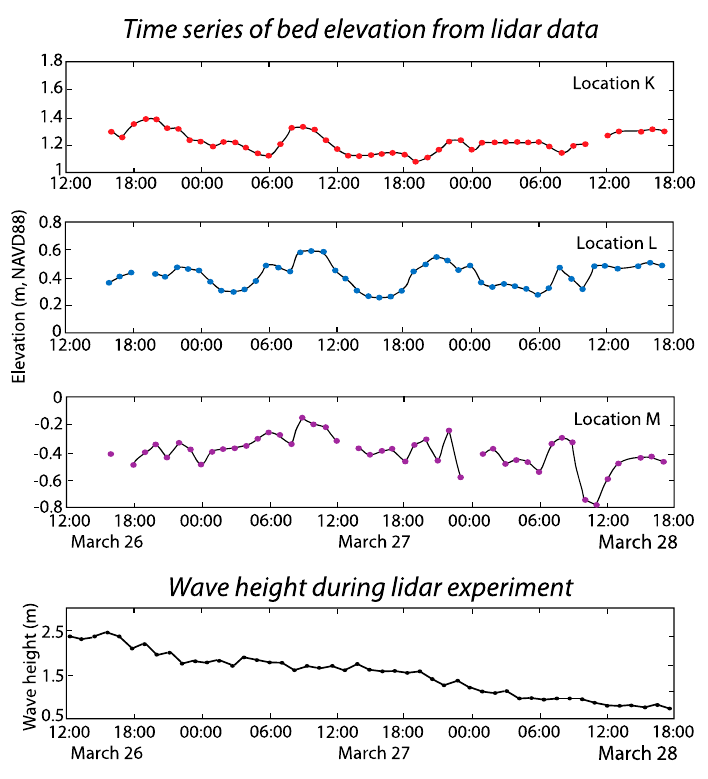
Figure 8. Two days of time series of bed elevation from the lidar at locations K, L, and M. Bottom panel shows wave height during the same period.